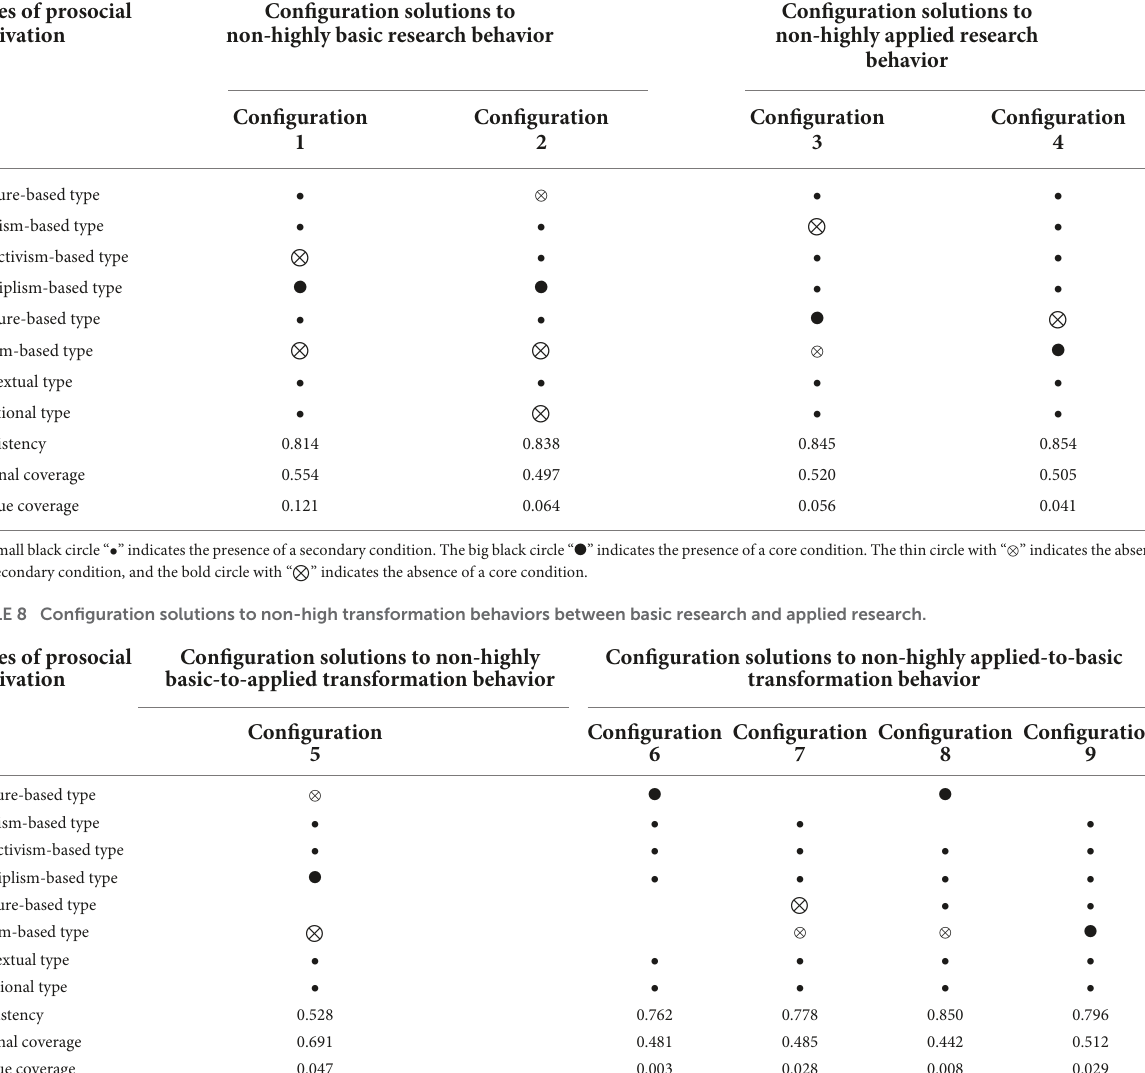
TABLE 7 Configuration solutions to non-highly basic research behavior and non-highly applied research behavior.